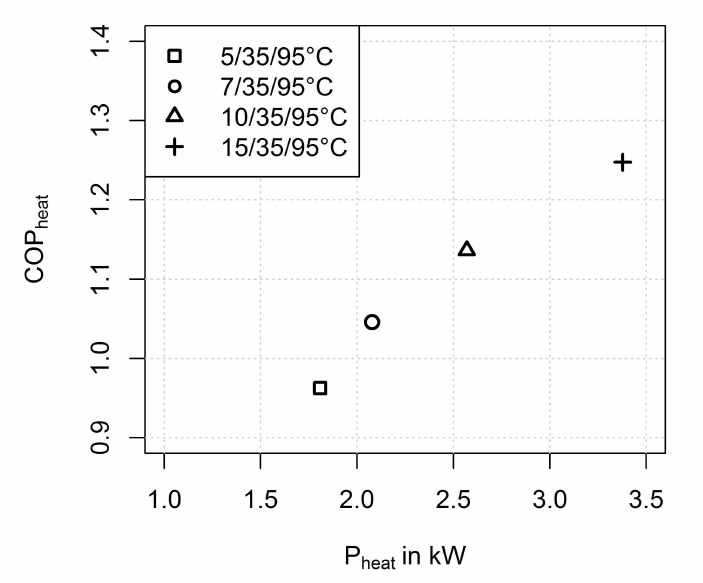
Figure 11. Efficiency and power for four different temperature conditions. We conducted all measure- ments shown here with the same half cycle time (200 s/400 s for desorption/adsorption). Due to the rising evaporator temperature the maximum possible loading difference increases and the tempera- ture lift (difference between evaporator temperature and adsorber temperature during adsorption) decreases. This corresponds with a higher efficiency as it can be expected from theory. The decreasing efficiency and power can partly be explained with the decreasing equilibrium loading difference (reached for very long cycle times) with decreasing evaporator temperature as shown in Figure 12. However, the calculated loading difference differs much more from the equilibrium loading difference for the measurement with 5 ◦ C as for the measurement with 15 ◦ C as shown in Figure 12.